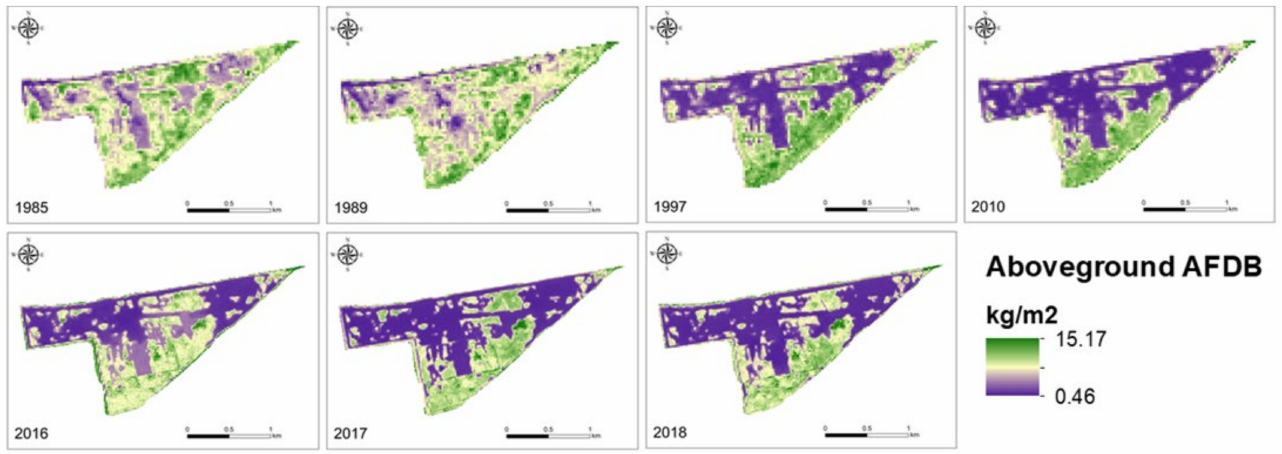
Figure 3. Maps of aboveground ash free dry biomass (AFDB) for each considered